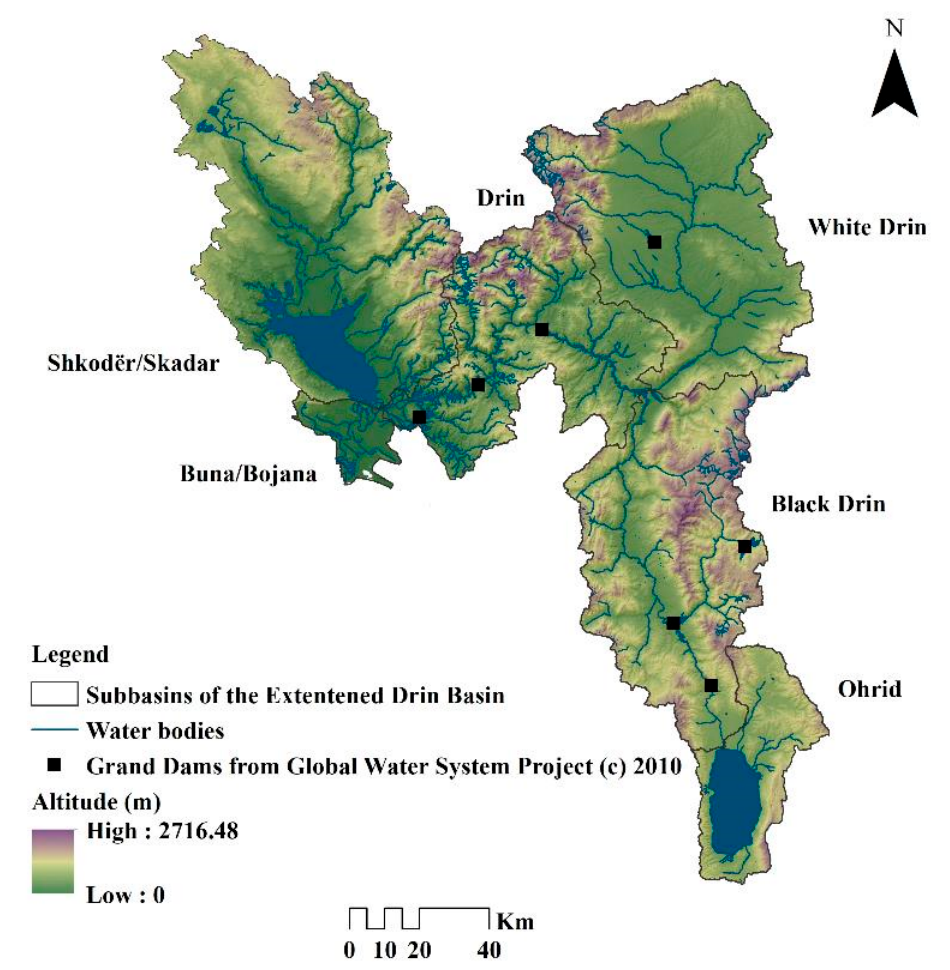
Figure 1. Extended Drin river basin.